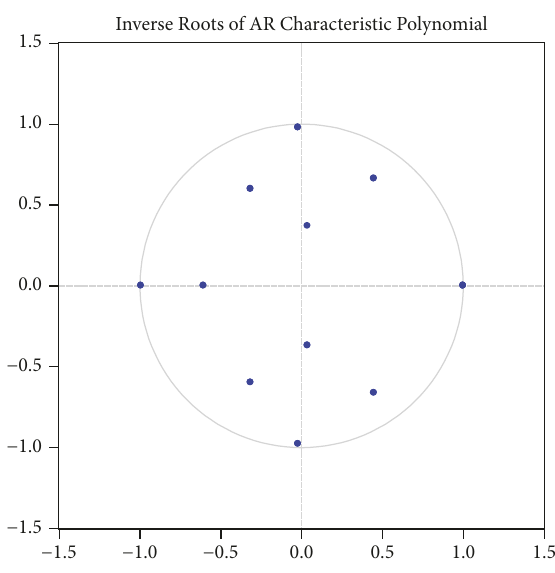
Figure 3: Residual stability test of ECM model.